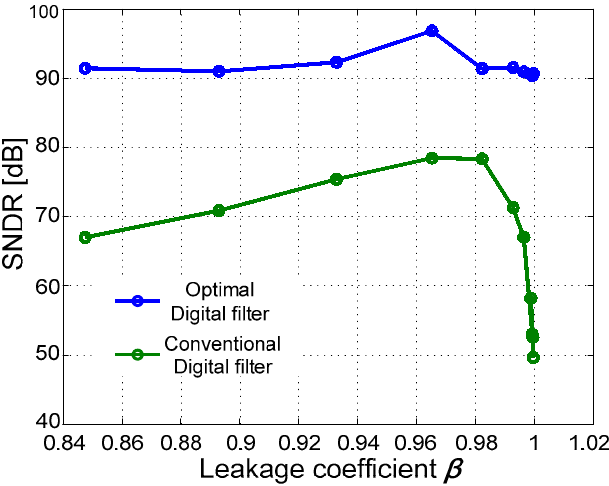
Figure 6. Comparison of signal-to-noise and distortion ratio (SNDR) versus leakage values with and without the optimal digital filter.